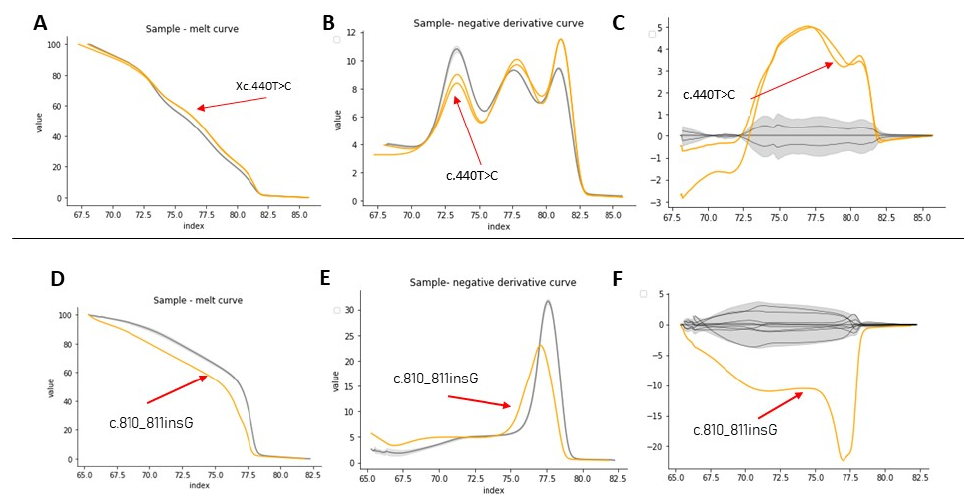
Figure 4. HRM analysis of exon 4 from samples Af3A/Af4A ( A – C ) and exon 7 from sample Af1B ( D – F ). In yellow, the positive control, in gray, the healthy controls. ( A – D ) Denaturation curves, X axis = temperature ( ◦ C), Y = normalized fluorescence (RFU). ( B – E ) Negative derivative plot (-dF/dT), (X axis = temperature ( ◦ C), Y = normalized fluorescence (RFU)). ( C – F ) Plot of differ- ences (X axis = temperature ( ◦ C), Y = normalized fluorescence (RFU)). Exons with a length greater than 300 bp presented melting curves with several melting domains. To improve sensitivity, analysis by denaturation domains was implemented